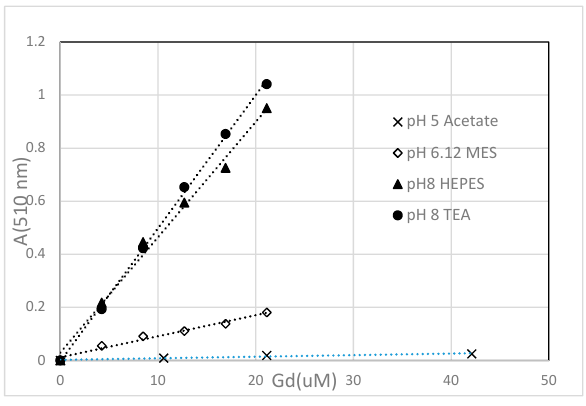
Figure 1. Absorbance at 510 nm as a function of the total Gd 3 + concentration was linear in all bu ff ers investigated. All of the bu ff ers were 0.100